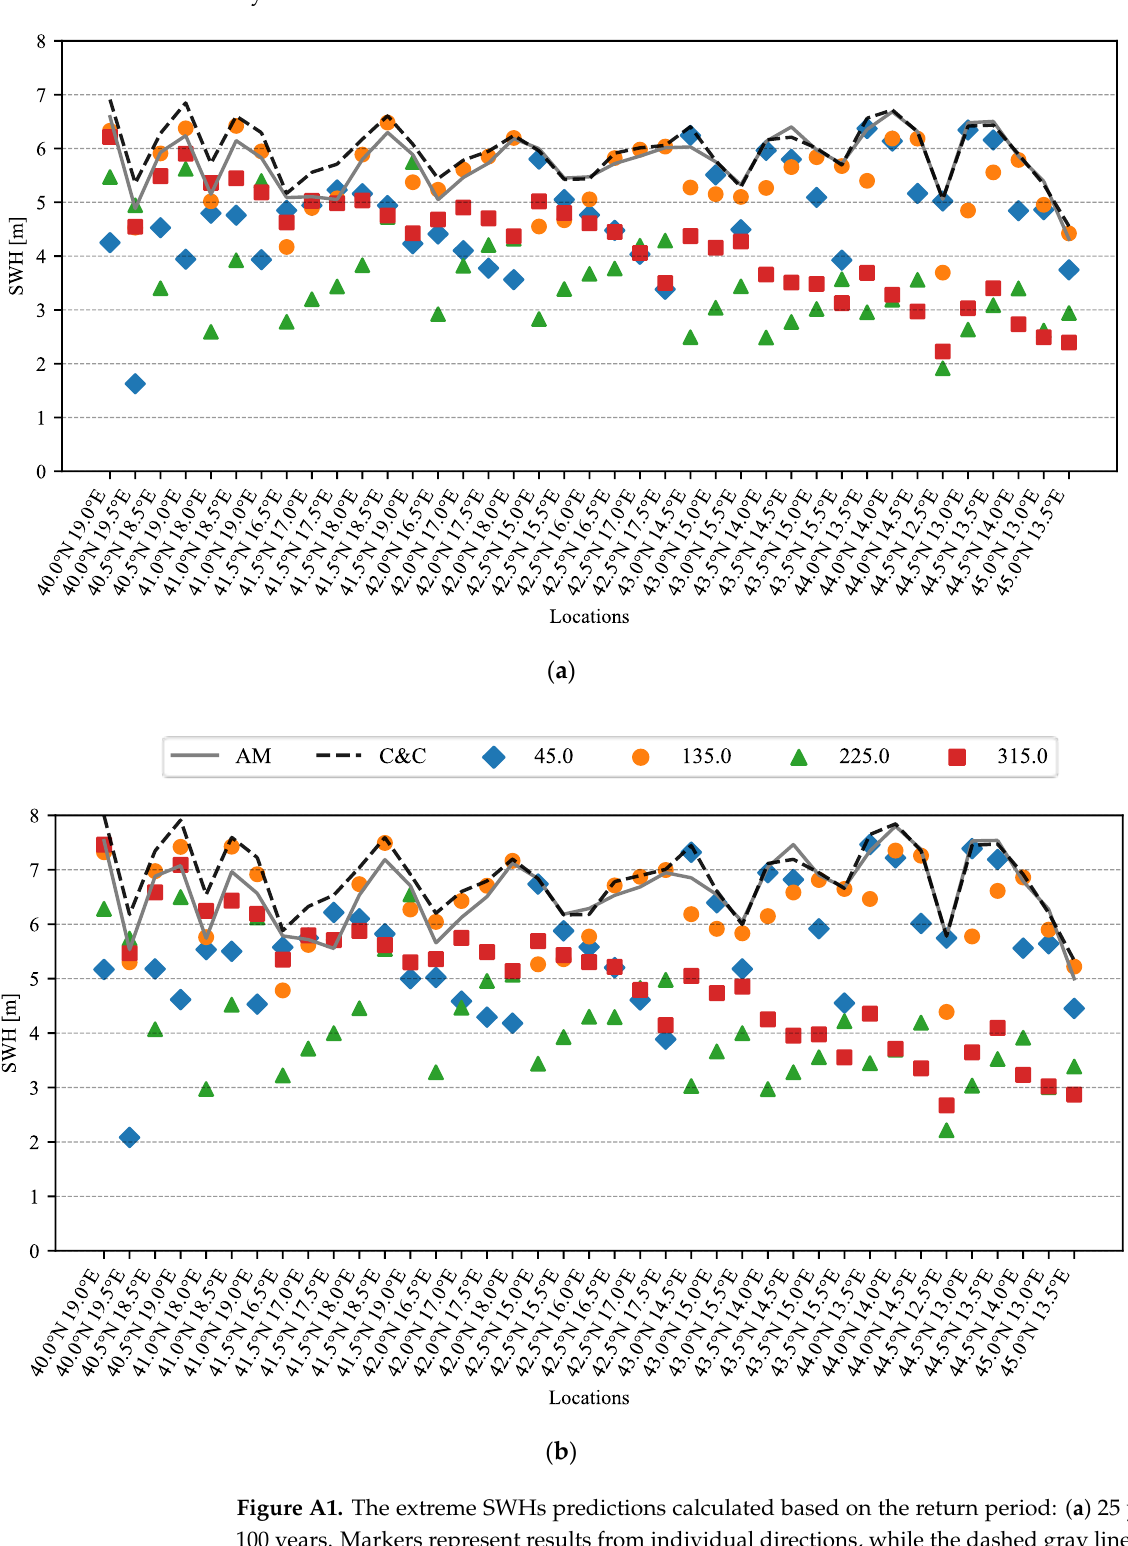
Figure A1. The extreme SWHs predictions calculated based on the return period: ( a ) 25 years; ( b ) 100 years. Markers represent results from individual directions, while the dashed gray line displays values obtained by the C–C approach combining DM.